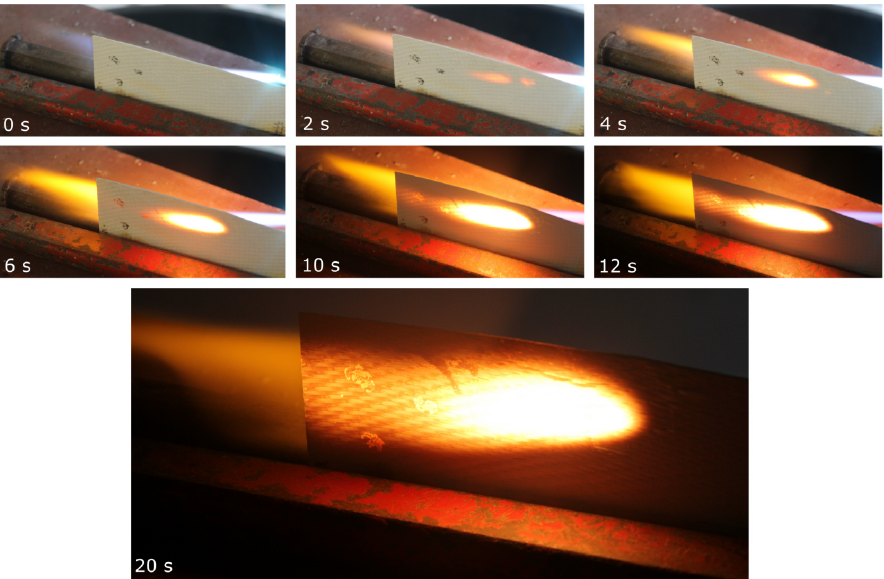
Figure 17. Heating of a sample of FW12 during oblique irradiation with an oxy-acetylene torch.